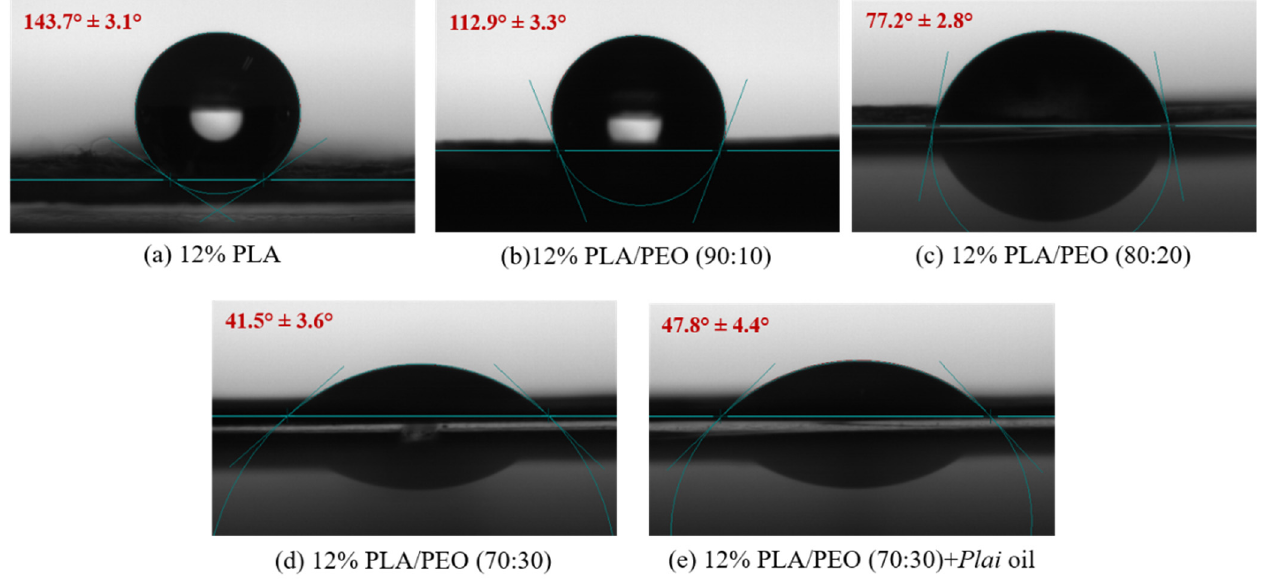
Figure 3. Water contact angles of ( a ) 12% PLA, ( b ) 12% PLA/PEO (90:10), ( c ) 12% PLA/PEO (80:20), ( d ) 12% PLA/PEO (70:30), and ( e ) 12% PLA/PEO (70:30) + Plai oil fiber membranes.